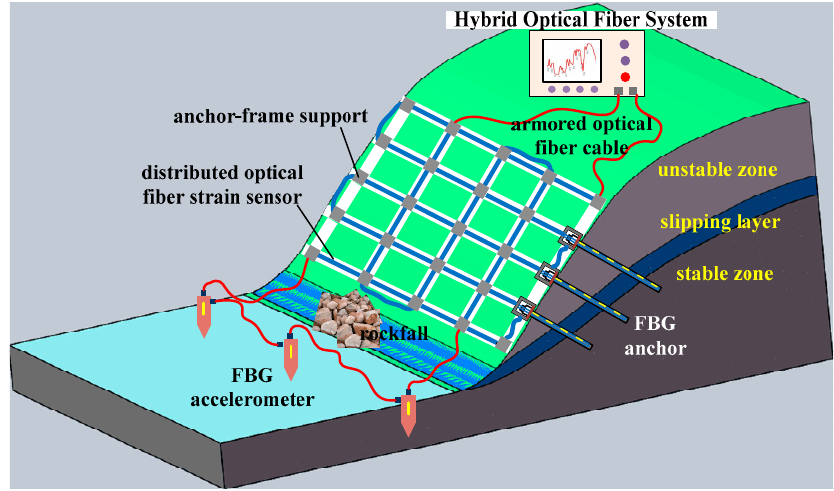
Figure 10. Multiparameter monitoring of a slope using the proposed hybrid system.